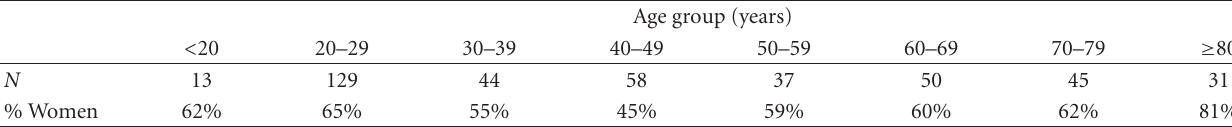
Table 2: Distribution of the 407 healthy participants by age group.